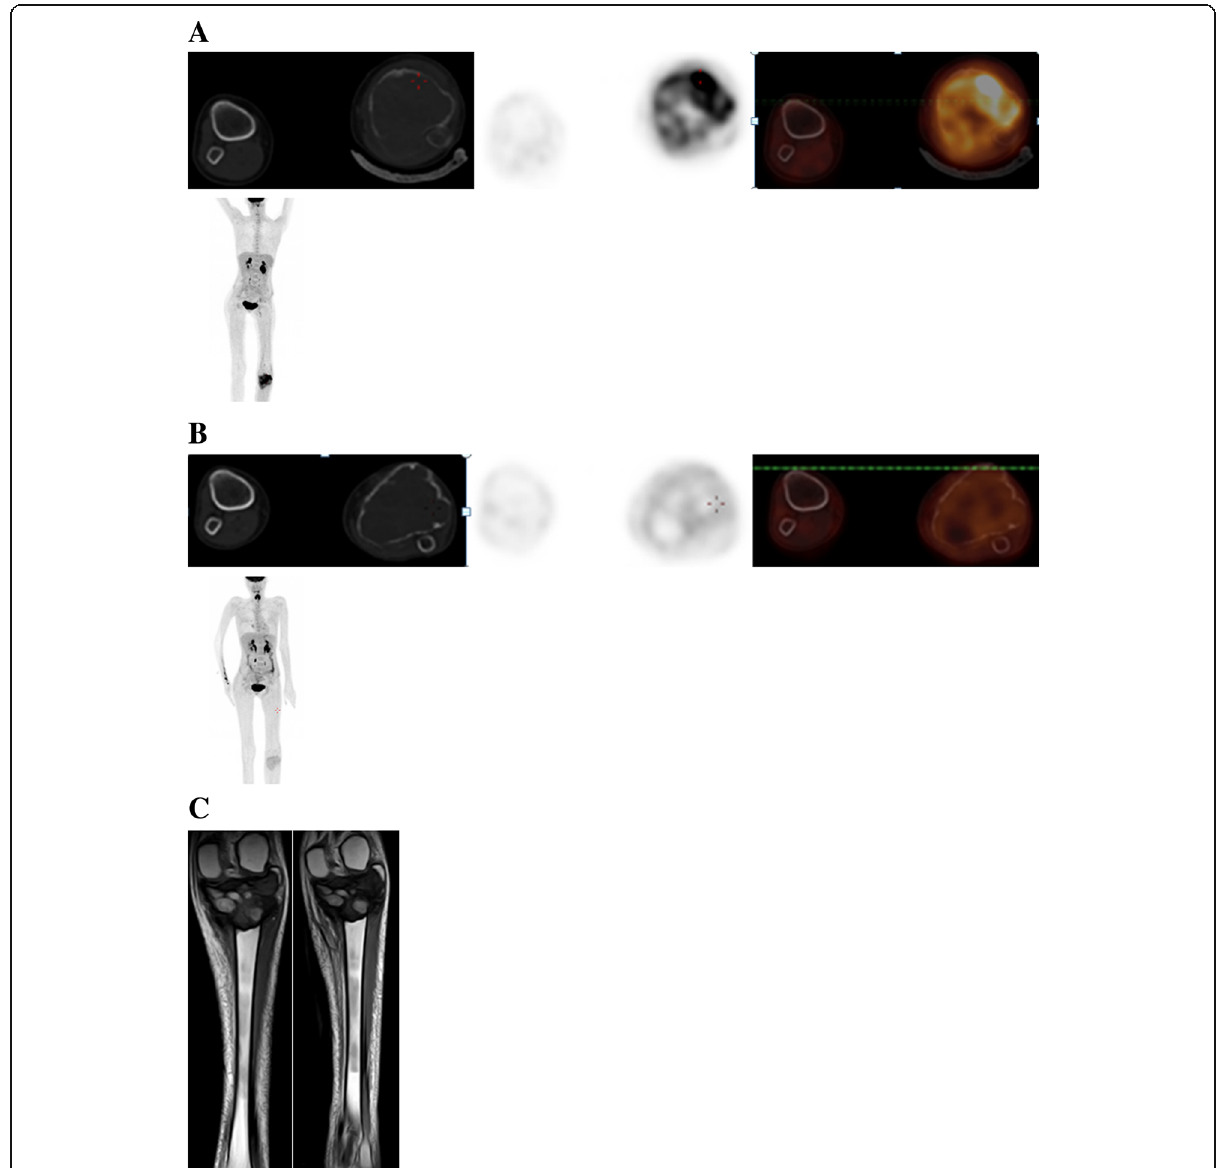
Fig. 7 A 14-year-old female patient suffered from left proximal tibia telangiectatic osteosarcoma. a Prechemotherapy PET/CT revealed metabolically active FDG left proximal tibial mass lesion (SUV=12.4). b After the end of treatment, PET/CT revealed no pathological uptake (SUV=1.8). The patient underwent limb salvage surgery and surgical pathology revealed good histological response (100% tissue necrosis). c No corresponding morphologic improvement was seen between the premanagement MRI (left) and postmanagement one